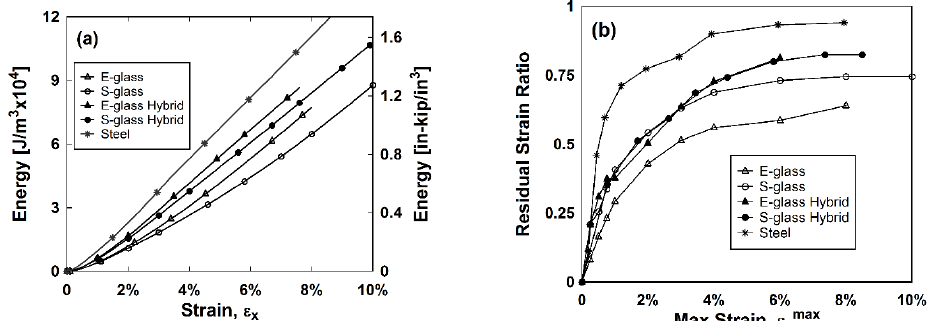
Figure 4. ( a ) The energy dissipated versus the maximum strain for each cycle and ( b ) the residual strain ratio versus the maximum strain for each cycle.